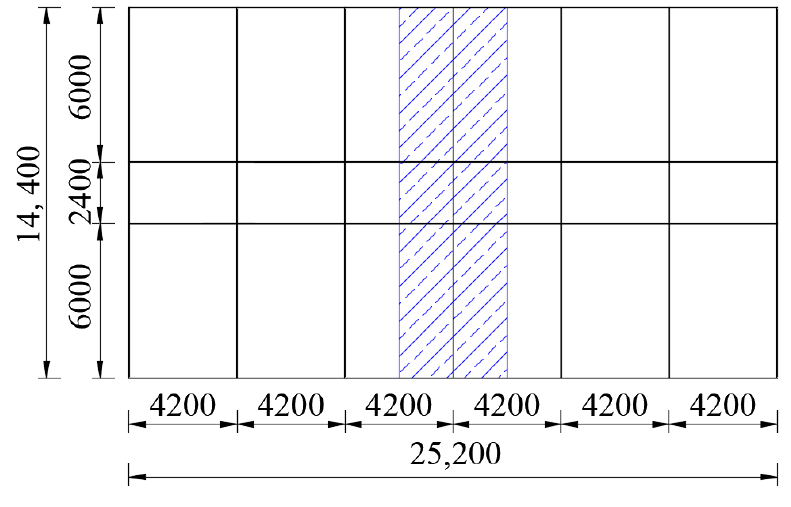
Figure 1. Layout plan of frame (unit: mm).